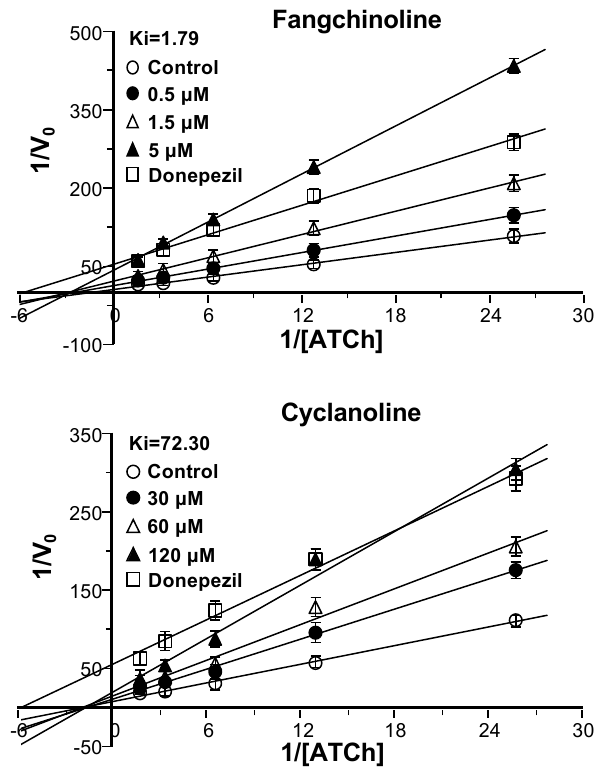
Figure 4. The enzyme kinetic analysis of AChE inhibition by fangchinoline and cyclanoline. Different doses of fangchinoline (0.5–5 µ M) and cyclanoline (30–120 µ M) were added to the AChE reaction system and preincubated at 37 ◦ C with the brain lysate, followed by the addition of a range of doses of ATCh (0.040–0.625 mM). The inhibition constants K i were estimated from the plots of the slope versus the concentration of tested drugs. Donepezil (25 nM) served as a positive control. The data are expressed as the mean ± SEM (standard error of mean) of three dependent assays, each with triplicate samples.